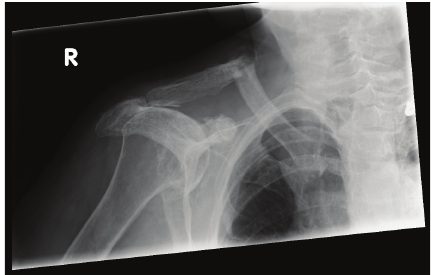
Figure 2: Follow-up radiograph at fracture clinic, four weeks following conservative management, demonstrating signs of callus formation of the right mid-clavicular transverse fracture. Superior cortical thickening and a small spike of the fracture fragments are also seen in this